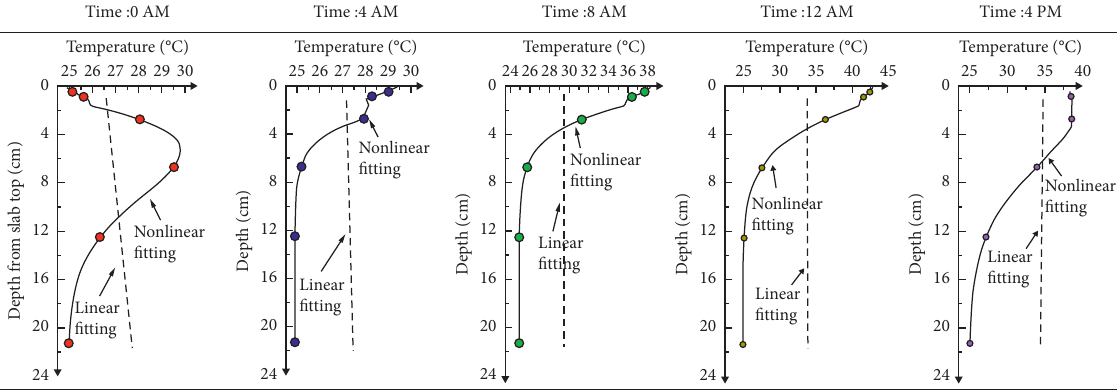
Figure 5: Distribution of temperature along slab thickness at slab